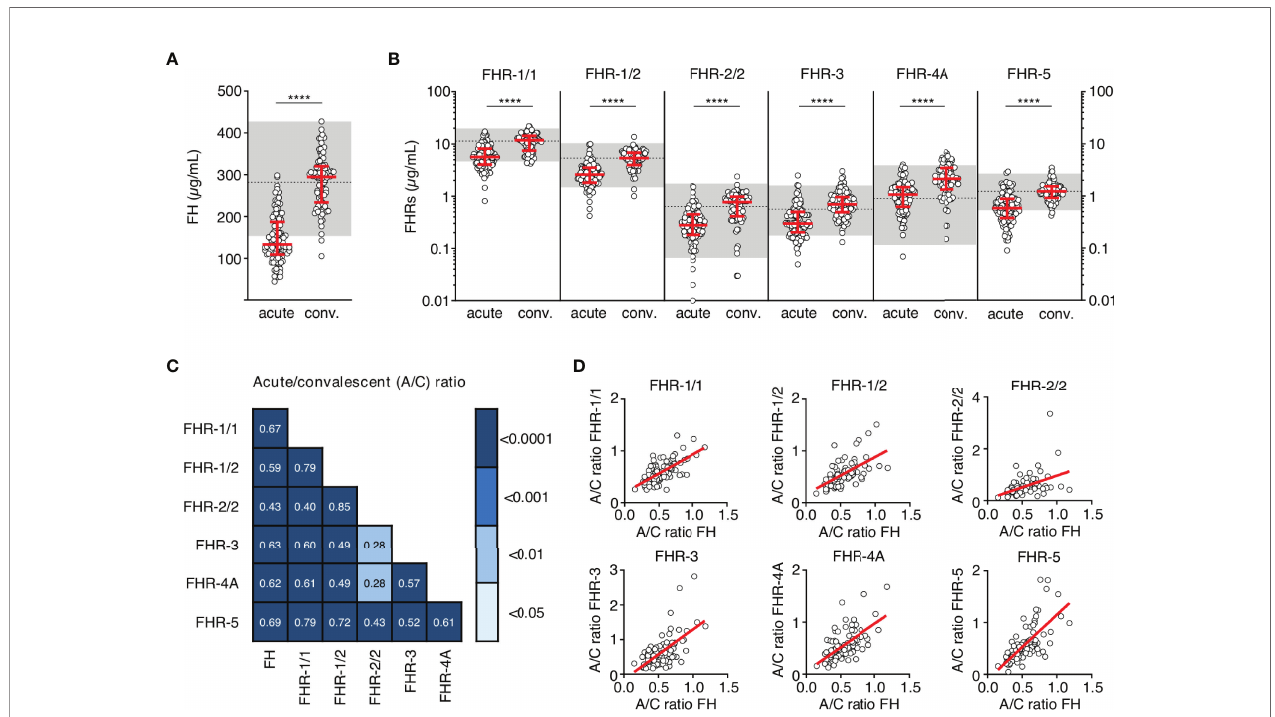
FIGURE 1 | FH family protein levels are low at the acute stage of MD. (A, B) Differences in FH, FHR-1/1 homodimers, FHR-1/2 heterodimers, FHR-2/2 homodimers, FHR-3, FHR-4A and FHR-5 homodimers as assessed at the acute stage (samples obtained during the fi rst or second day of hospitalization, n